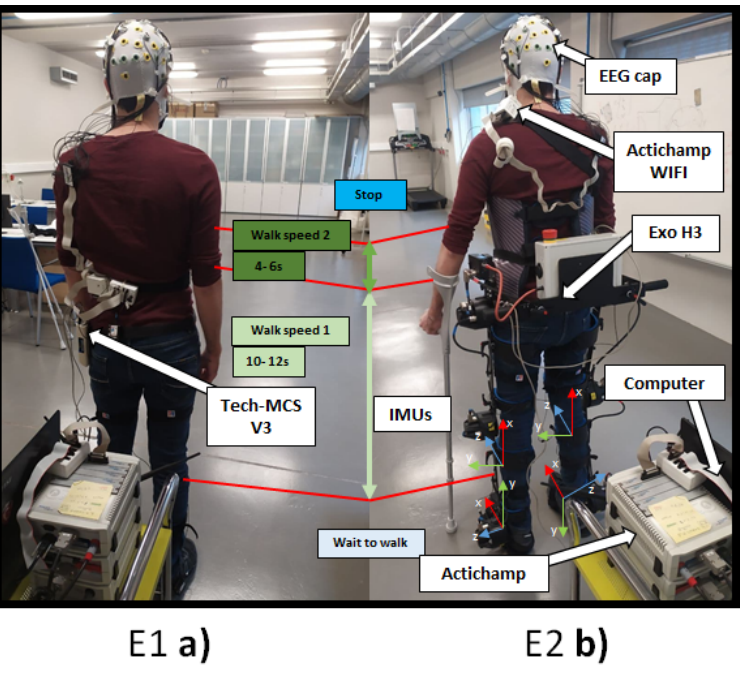
Figure 1. Experimental setup for E1 and E2 experiments. ( a ) E1: The subjects use the EEG acqui- sition equipment and IMUs. ( b ) E2: The subjects use in addition the H3 exoskeleton. During both experiments, subjects walk during 10–12 s at a reduced constant speed and then, at their own will, increase or decrease their current speed. After that, they continued walking for 2–3 s before stopping. This repetition was performed several times. This figure shows the approximate areas (between red lines) of the different phases of the protocol in both walking directions of the experimental room. Additionally, in E2 protocol, the exoskeleton was in passive mode for the model training while in the test phase was controlled in